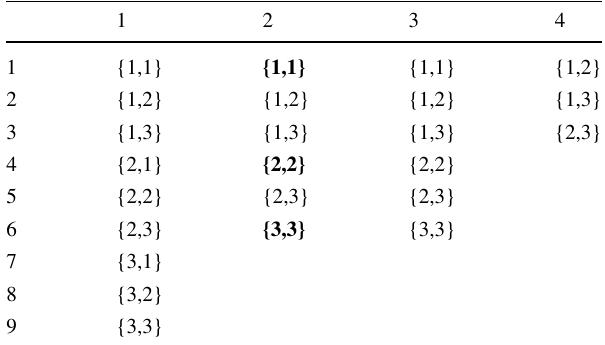
Table 15 Independent WCs in each 2F category. Numbers between curly brackets refer to the WC flavour indices. Elements in bold denote real WCs. Columns refer to symmetry categories, while rows just count